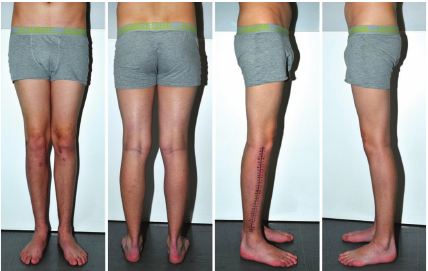
Figure 4: After implant removal, leg axis was normal and leg length